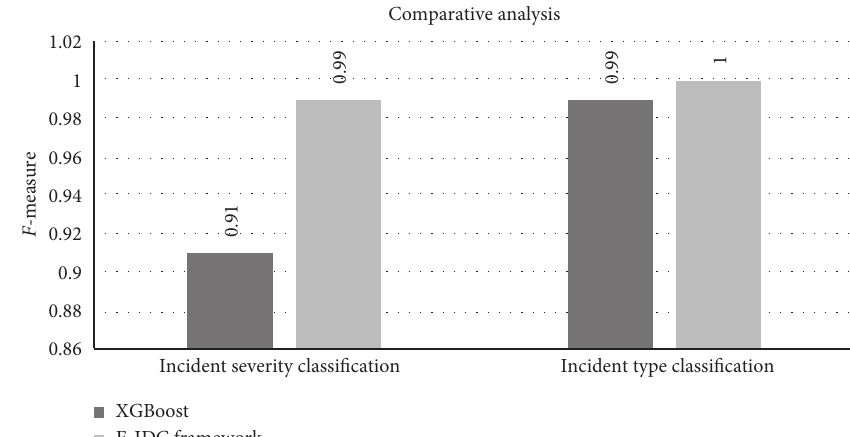
Figure 10: Comparison with state-of-the-art ensemble